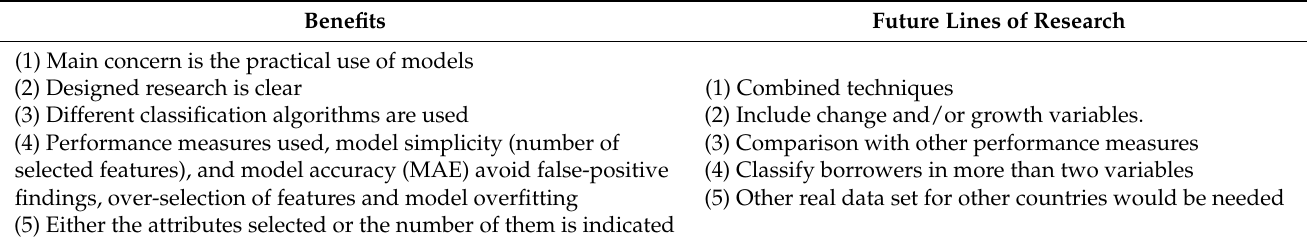
Table 9. Benefits and future lines of research methodology proposed.